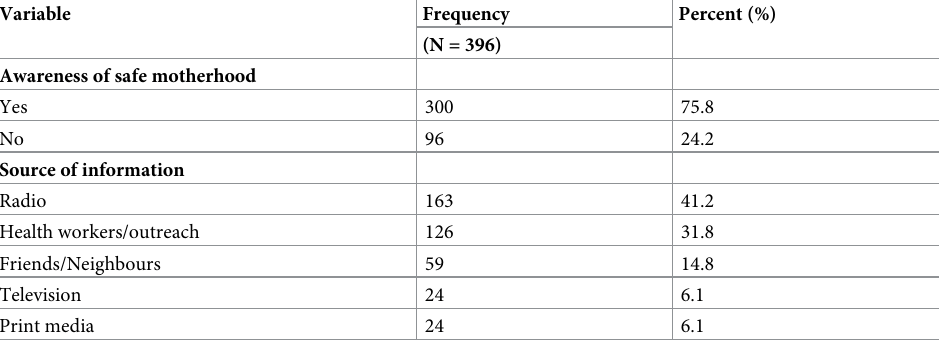
Table 2. Awareness of safe motherhood and the main source of information among men in the rural Ebonyi community.